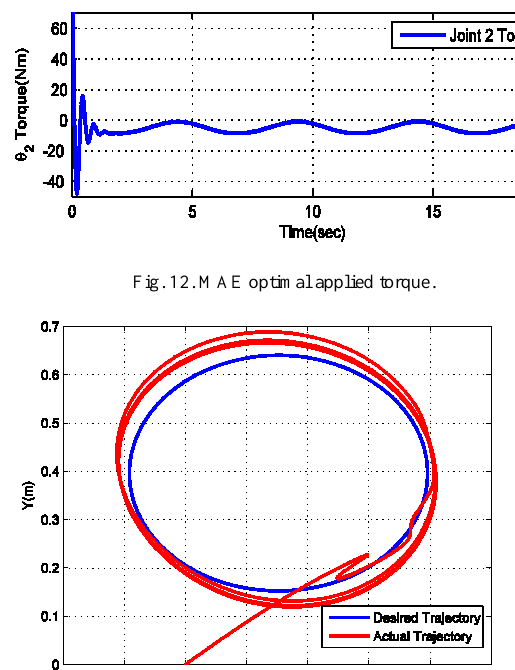
Fig. 13. MAE robotic arm trajectory in XY plane.